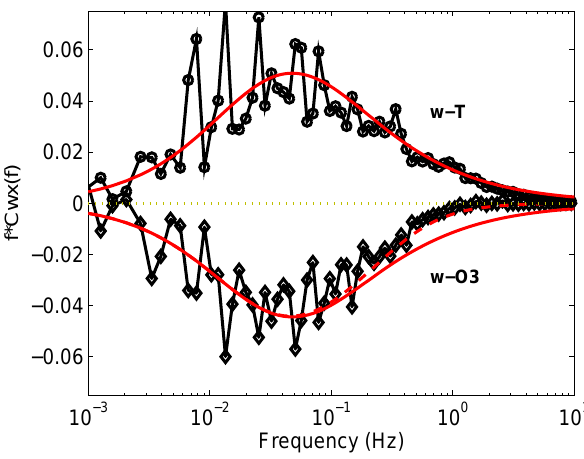
Fig. 8. Four-hour average cospectra from ozone flux measurements over land at the Table Mountain, CO, test site (DOY 152, 2006). Diamonds represent ozone in ppbms − 1 and circles the sonic tem- perature in Kms − 1 . The solid lines are the Kaimal et al. (1972) cospectral model fits; the dashed line shows the result of the fil- tered/modeled result for